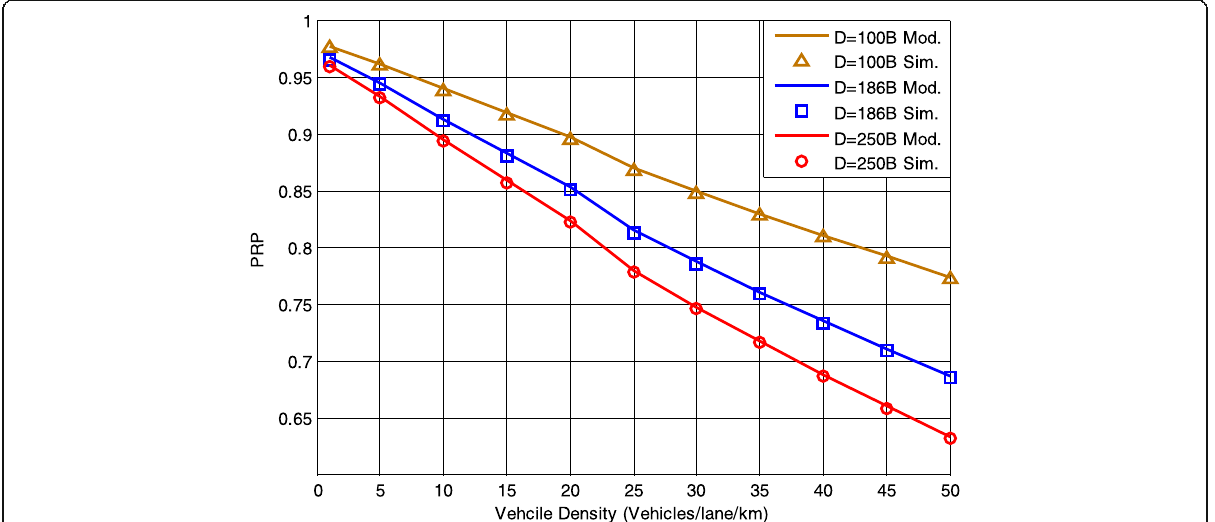
Fig. 13 Comparison of analytic model and simulation results of PRP with hidden terminal collisions for various BSM data sizes with respect to vehicle density, W